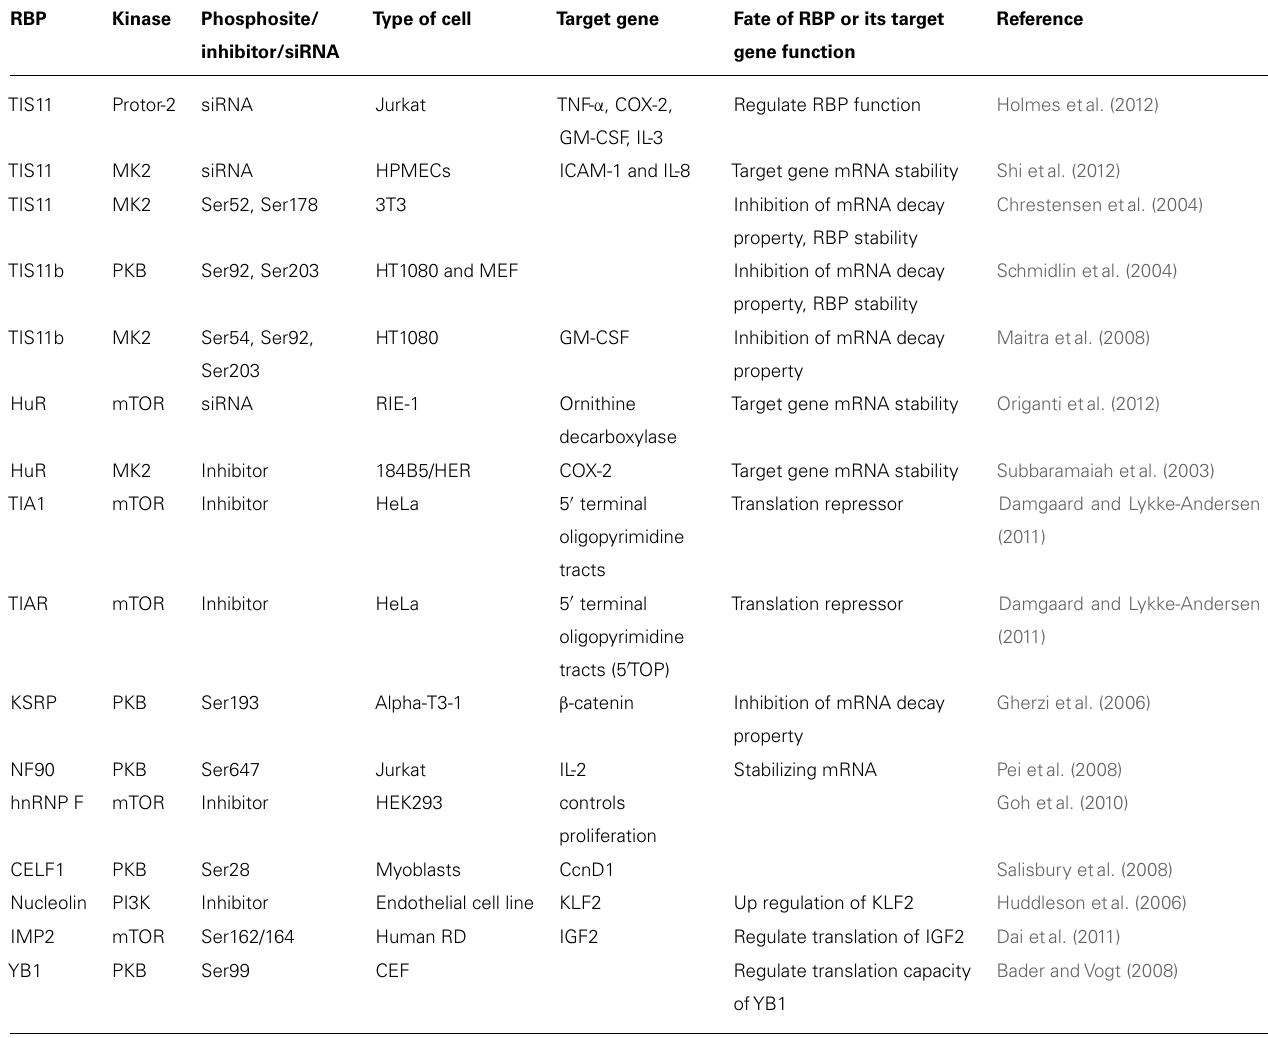
Table 1 | Representative list of signaling kinases regulating RBP